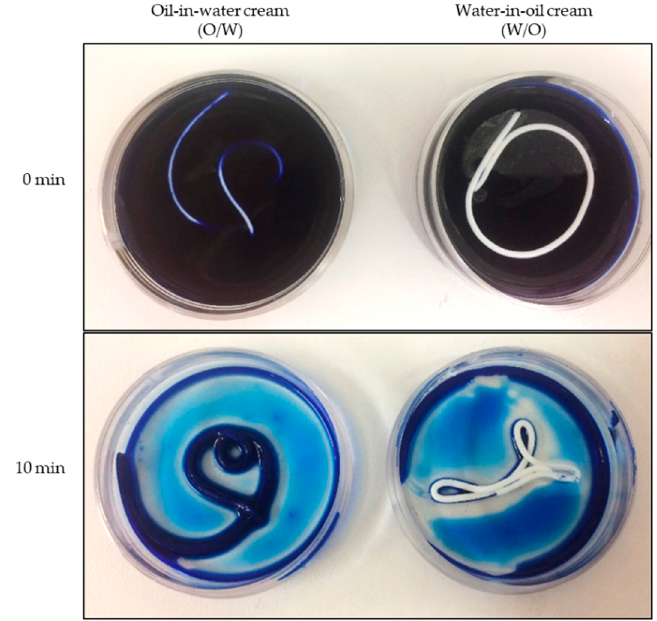
Figure 3. Verification of the O/W and W/O formulation type using methylene blue staining. A small part of both creams was squeezed from the tube into an aqueous 0.1% methylene blue solution. After 10 min, the methylene blue solution was removed and the blue staining of the cream was verified. Blue staining of the creme indicates a O/W formulation.